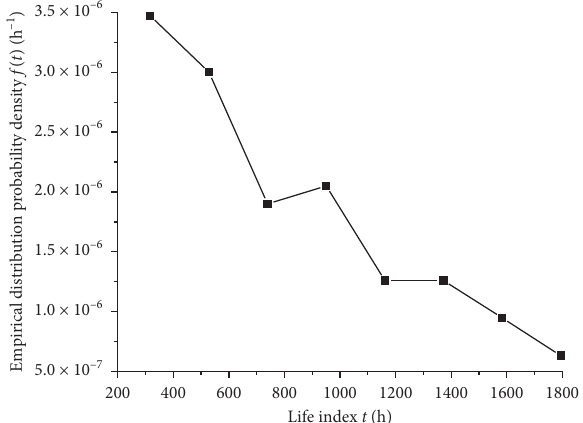
Figure 3: Probability density of empirical distribution.